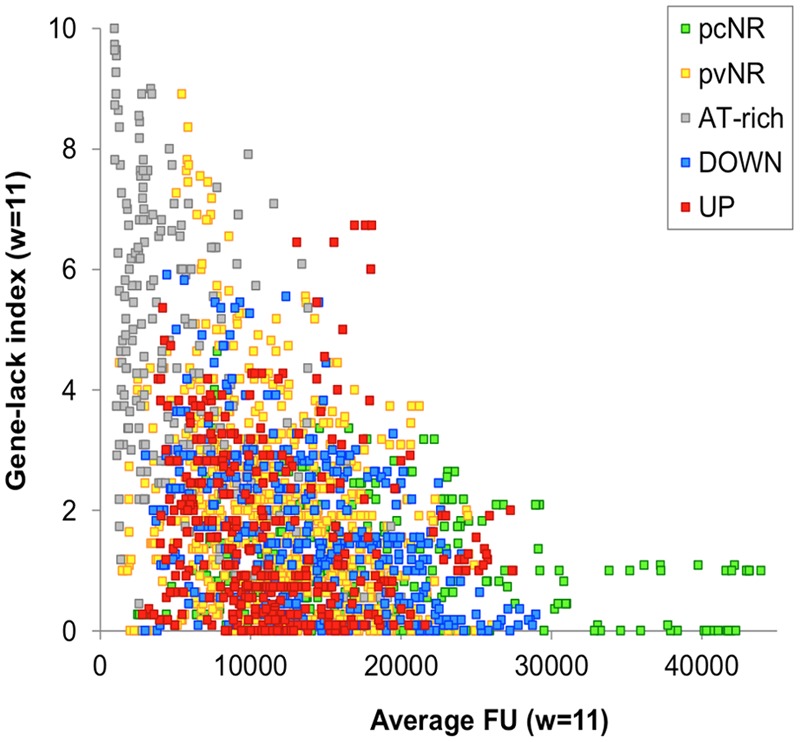
Evidence for conservation of UP and DOWN domains in S. pneumoniae. Relationship between the gene-lack index and gene expression (fluorescent units, FU) in S. pneumoniae R6 as detected in high density microarrays. A total of 12 genome sequences (from 11 clinical isolates and R6) were analyzed. Genes of clinical isolates were considered equivalent to those of R6 when their products shared ≥80% similarity over ≥80% of the sequence length. An 11-gene window (about 10 kb) was contemplated.